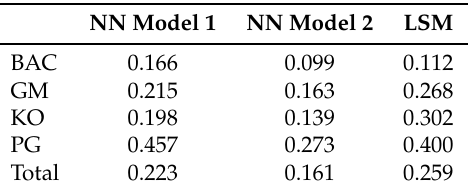
Table 6. RMSE per